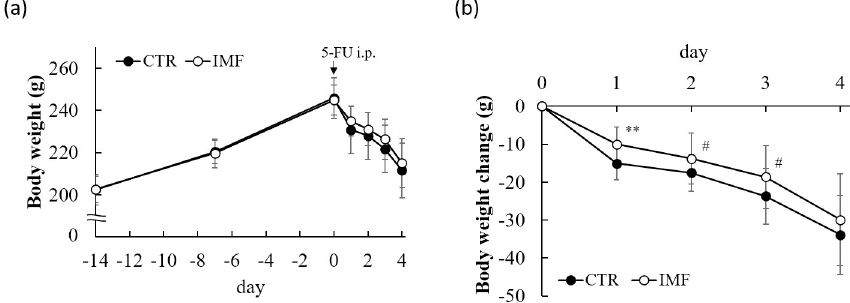
Fig 1. Body weight change over time in the CTR and IMF rats. ( a ) body weight and ( b ) body weight change from day 0. Values are means ± standard deviations. # P < 0.1, �� P < 0.01, vs. CTR group.